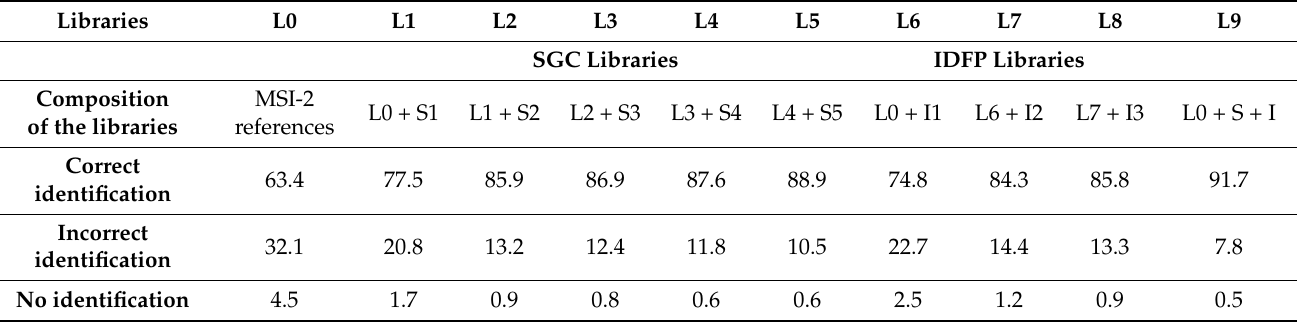
Table 1. General results (%) of the